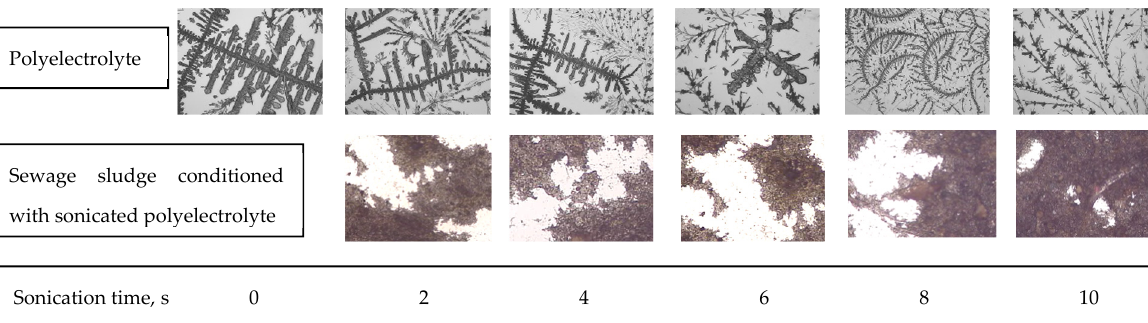
Figure 6. Specific resistance of sewage sludge conditioned with sonicated polyelectrolyte.